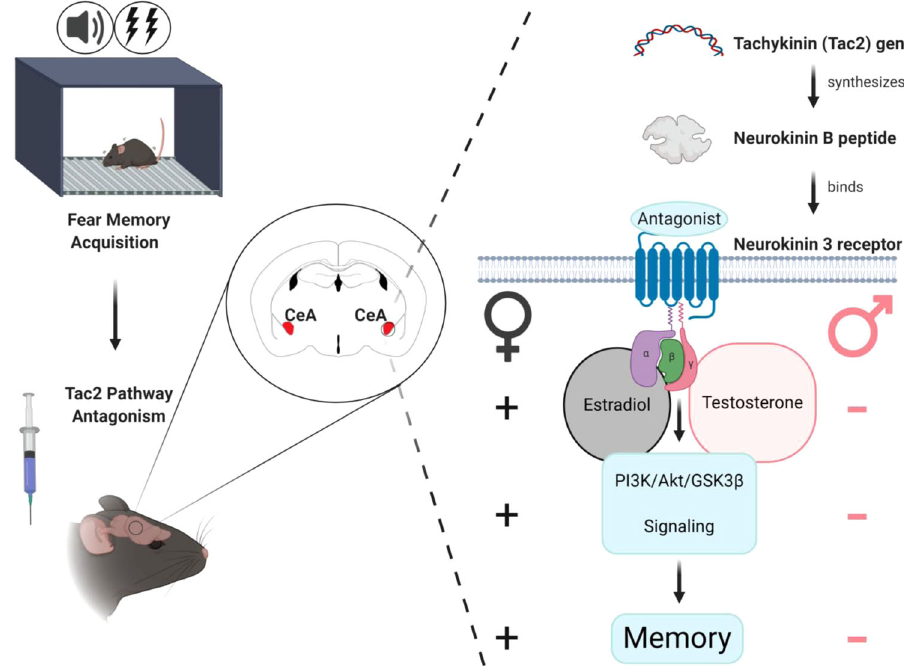
Fig. 7 Graphical summary. A graphical overview of this